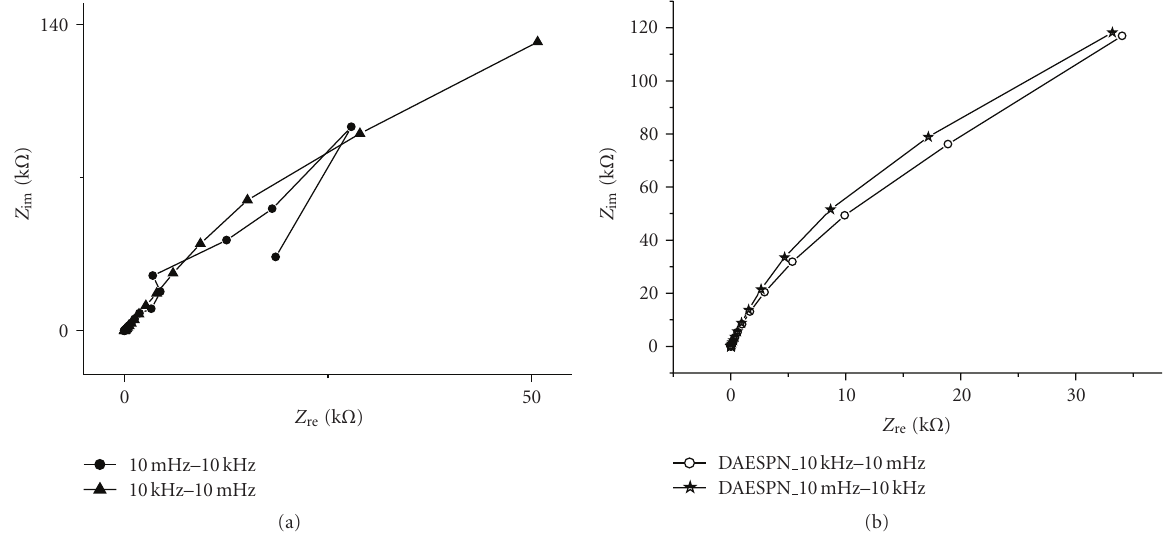
Figure 3: Nyquist plot of SS in the absence and presence of 1 × 10 − 3 M DAESPN in 3.0M NaCl